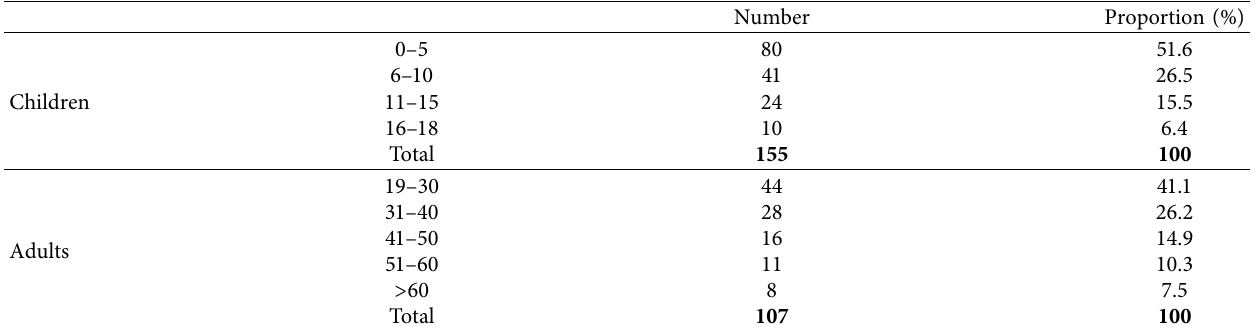
Table 1: Age distribution of 155 children and 107 adults with AD in the Dermatology Department of the CNHU-HKM in Cotonou